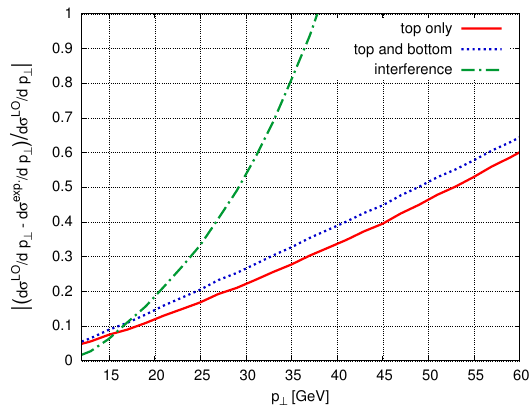
Figure 1 . Di(cid:11)erences between leading-order distributions and their logarithmic contributions, normalized to the leading-order results. The three curves show the case for top quark (solid/red), top and bottom quarks (dotted/blue), and top-bottom interference (dot-dashed/green). See text for